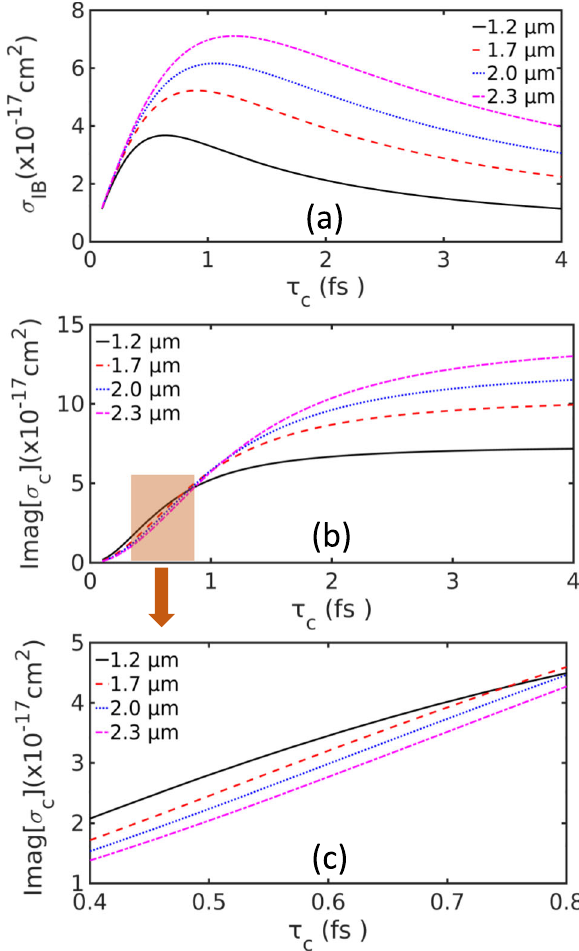
Fig. 4 Calculations of collisional ionization cross-section and plasma defocusing as a function of electron collision time. a The inverse Bremsstrahlung coef fi cient σ IB = Real [ σ c ω ð Þ ]), which is related to collisional ionization, versus electron collision time for a few wavelengths. b , c Dependence of plasma defocusing (Imag [ σ c ω ð Þ ]) on electron collision time ( τ c ) at λ ¼ 1.2 μ m (black solid line), λ ¼ 1.7 μ m (red dashed line), λ ¼ 2 μ m (blue dotted line), and λ ¼ 2.3 μ m (magenta dashed-dotted line). Plasma defocusing increases with increasing wavelength for τ c > 1 fs, whereas it decreases with increasing wavelength for τ 1 fs as shown in c , c < which is a zoomed-in fi gure for the shaded area in b